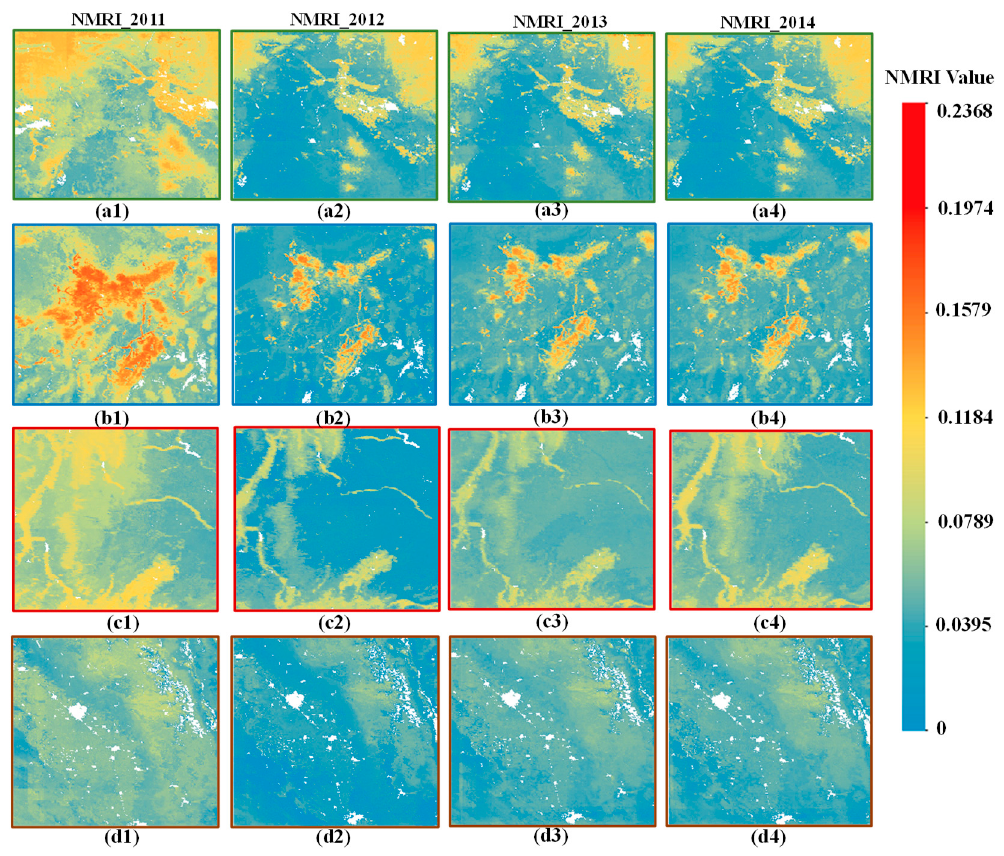
Figure 15. 500 m enlarged NMRI results of the four frame areas in Figure 13, from 2011 to 2014.